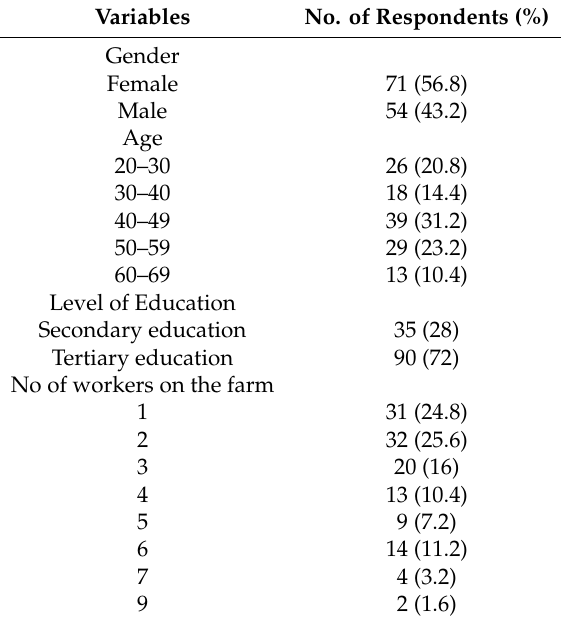
Table 3. Demographic structure of respondents ( n =